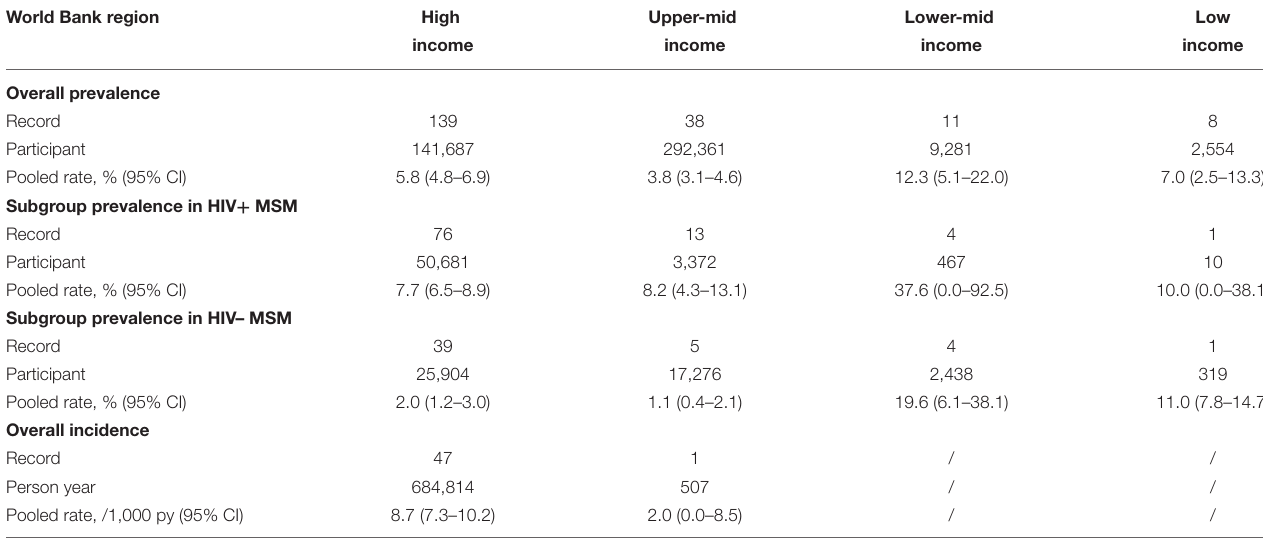
TABLE 2 | Estimated of anti-HCV prevalence and incidence by income level. World Bank region High Upper-mid Lower-mid Low income income income